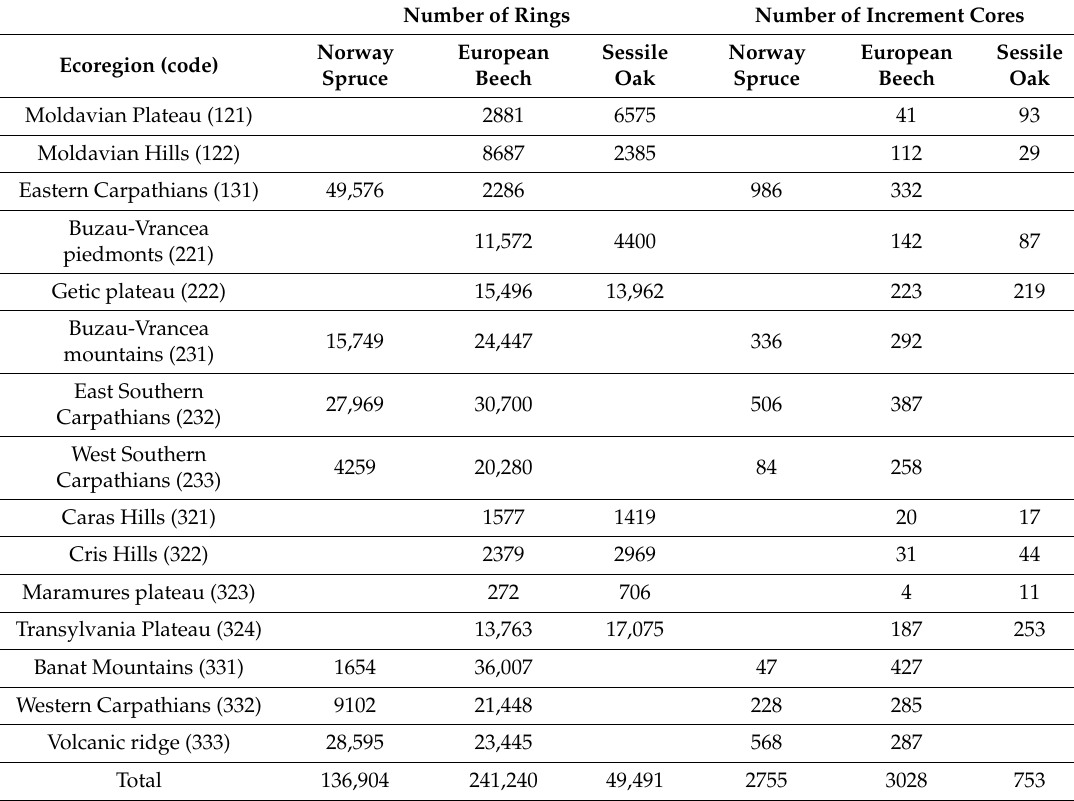
Table 2. Size and number of annual rings and increment cores across ecoregions and